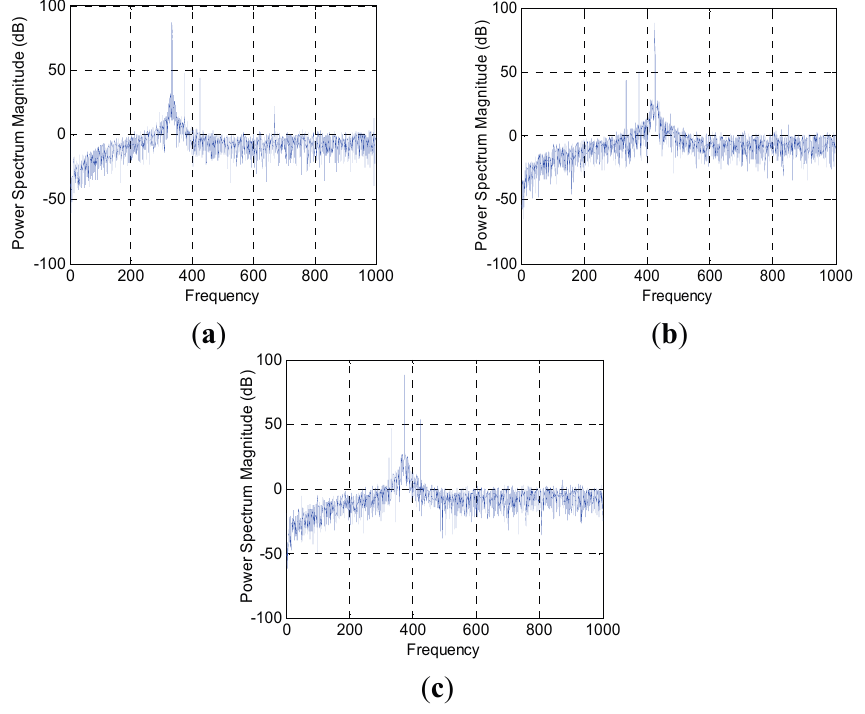
Figure 2. Frequency spectrum of RLGs in LINS. ( a ) Gx, ( b ) Gy, ( c ) Gz.